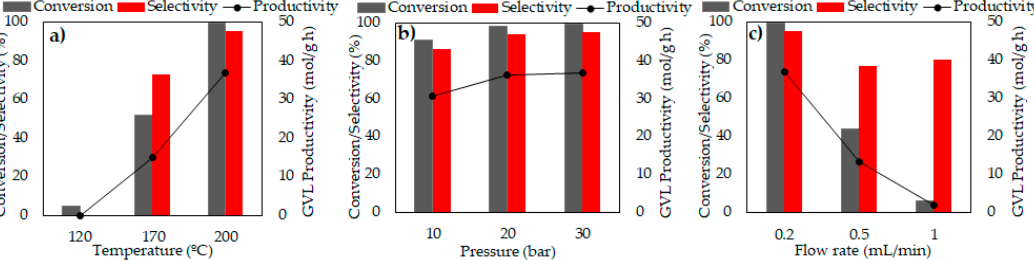
Figure 5. Catalytic performance of ZrO 2 /Si-SBA-15 in the liquid-phase continuous transformation of ML into GVL under different reaction conditions: ( a ) temperature, ( b ) pressure, ( c ) ML solution flow rate. Reaction conditions: 0.3 M ML solution, 0.1 g of catalyst were fixed for all the experiments, ( a ) 0.2 mL/min flow rate, 30 bar pressure; ( b ) 0.2 mL/min flow rate and 200 ◦ C reaction temperature and finally, ( c ) 30 bar pressure and 200 ◦ C reaction temperature. Time on stream 1 h.